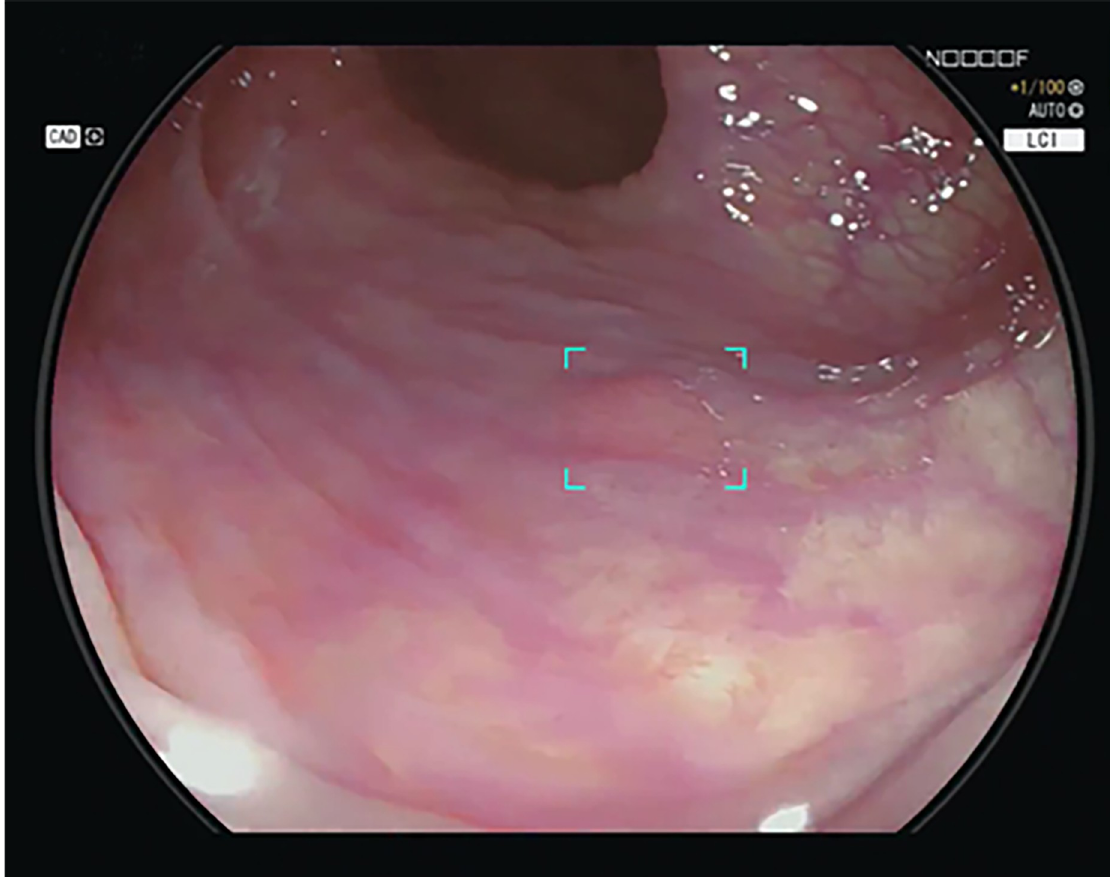
Fig 1. The AI system highlights the polyp by placing a colored box around it. In addition, the detection is accompanied by a specific sound. Here, the polyp is located in the central portion of the endoscopic image. Therefore, the specific visual assist circle is not activated compared with the polyp in Fig